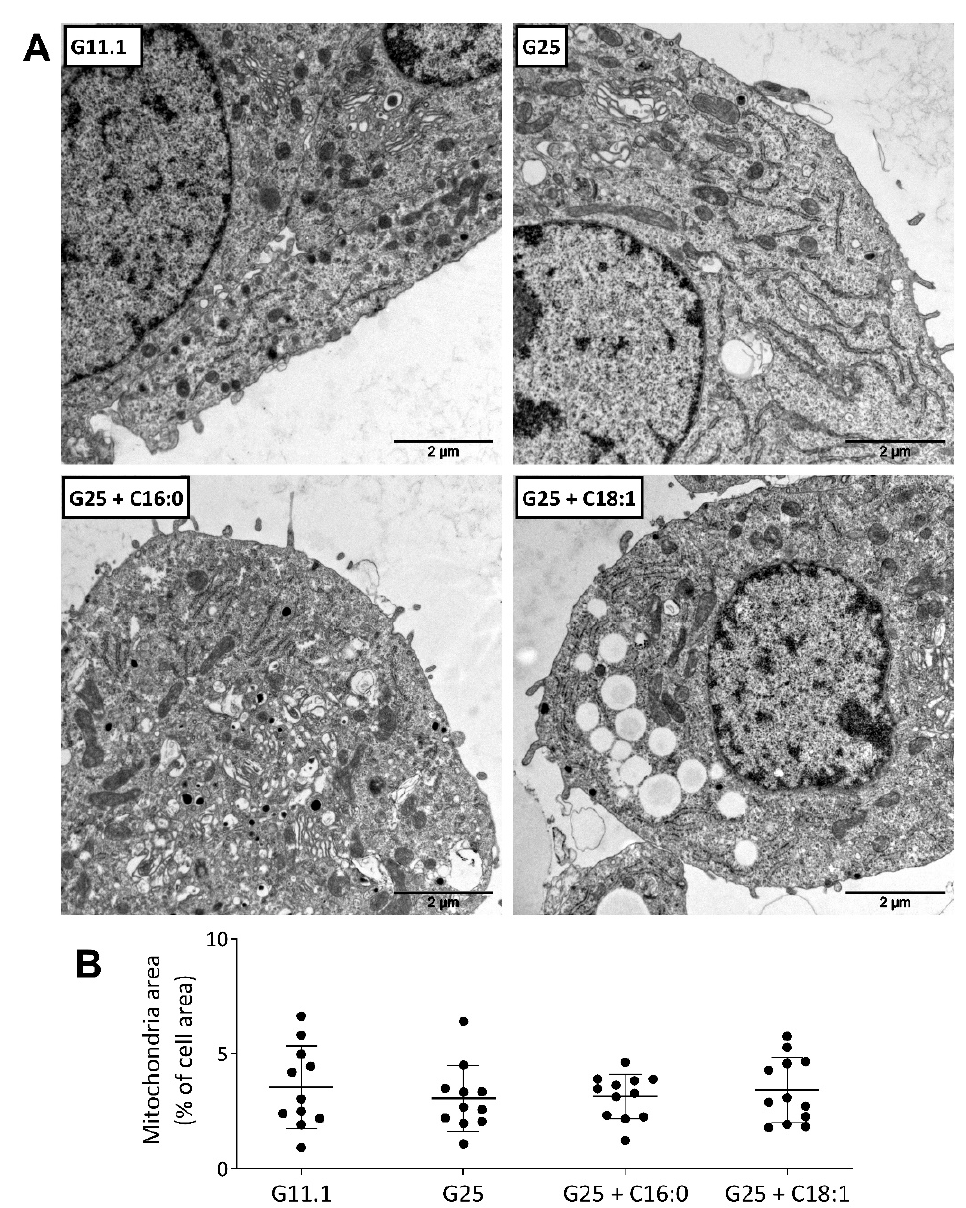
Figure 2. Ultrastructure of INS-1E β -cells following glucolipotoxic culture conditions. Cells were exposed to standard 11.1 mM (G11.1) and high 25 mM (G25) glucose concentrations without (BSA) or with 0.4 mM palmitate (C16:0) or oleate (C18:1) for 3 days. ( A ) Representative electron micrographs of cells cultured at G11.1 and G25 plus C16:0 and C18:1, scale bar 2 µ m. ( B ) Quantitative analysis of intracellular area occupied by mitochondria. Results are presented as means ± SD, n = 11–12.